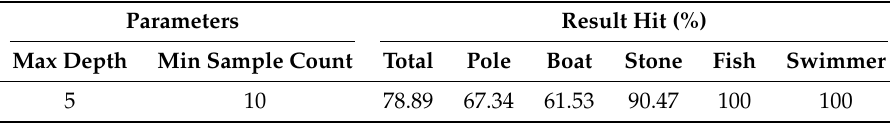
Table 11. Balanced 10D Feature results—Random Trees.